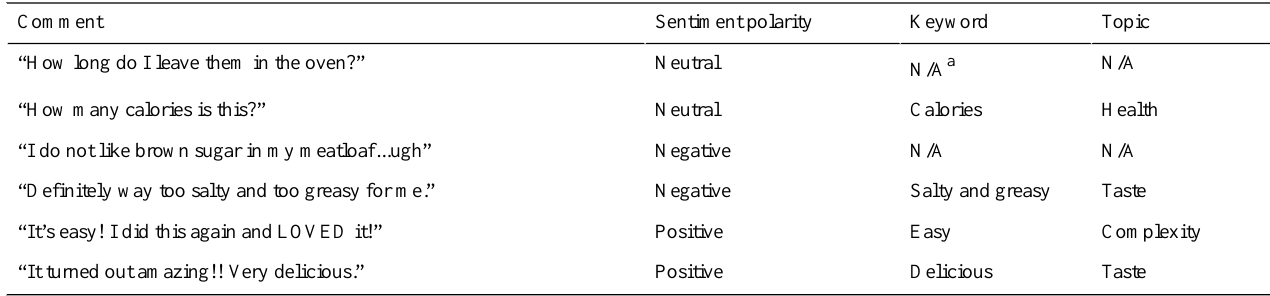
Table 2. Comment samples and